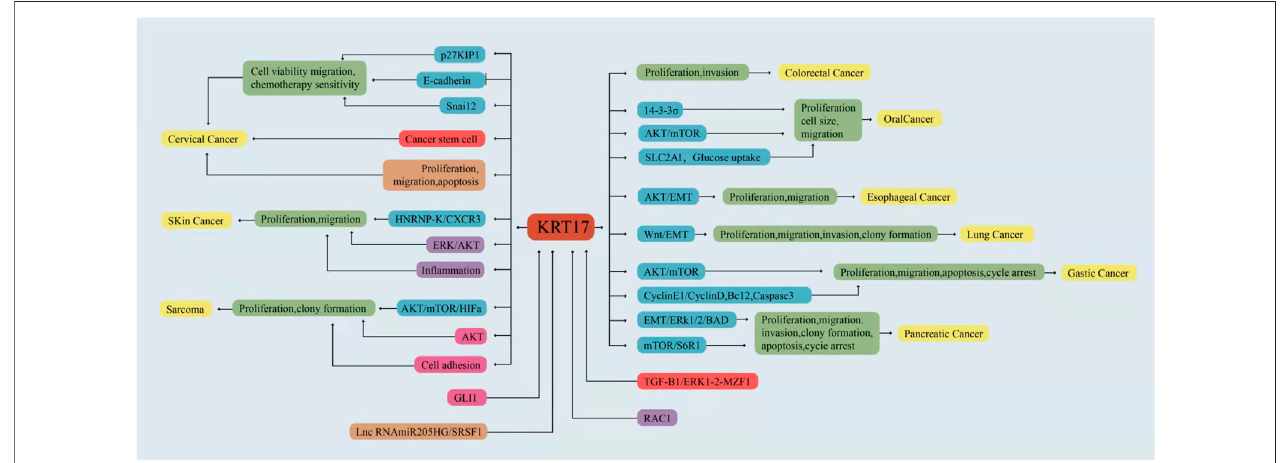
FIGURE 3 | KRT17 is involved in the regulation of different signaling pathways in different malignant tumours.